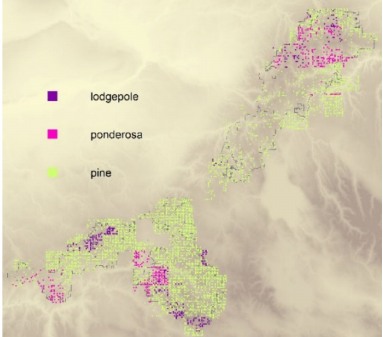
Figure 2. Clustered distributions of identified lodgepole and ponderosa pine species compared to distribution of unidentified